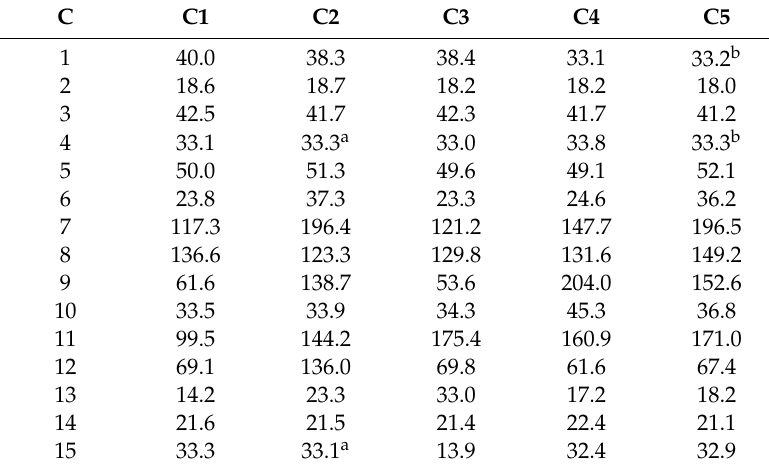
Table 2. 13 C-NMR (150 MHz, CDCl3. δ in ppm) results for